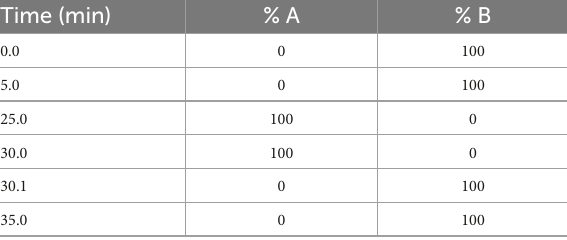
TABLE 1 Liquid chromatography (LC) gradient profile.